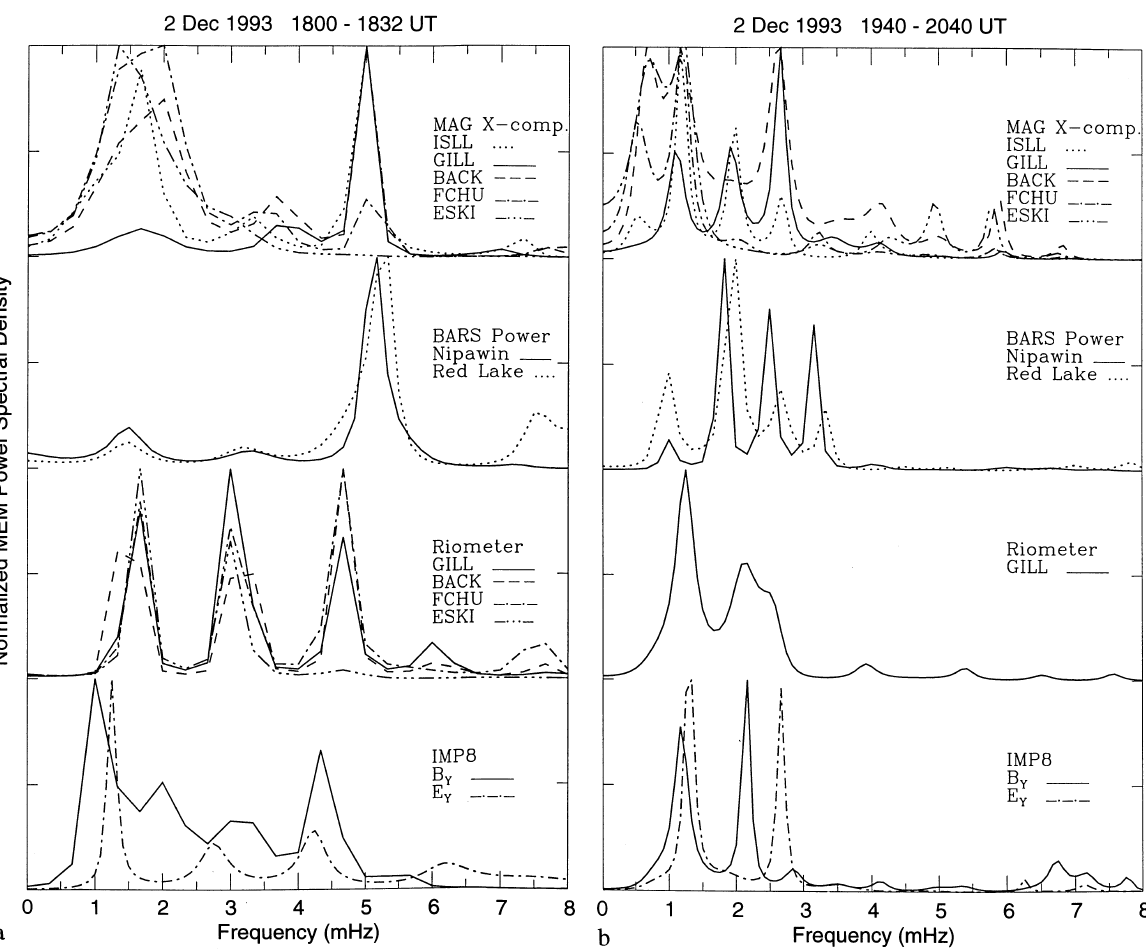
Fig. 11a,b. Normalized MEM power spectra of pure state filtered IMP-8 IMF, riometer absorption, BARS backscatter power, and ground magnetometer data for a event 1 and b event 2. BARS backscatter power at range gates near BACK ( left panel ) and GILL ( right panel )